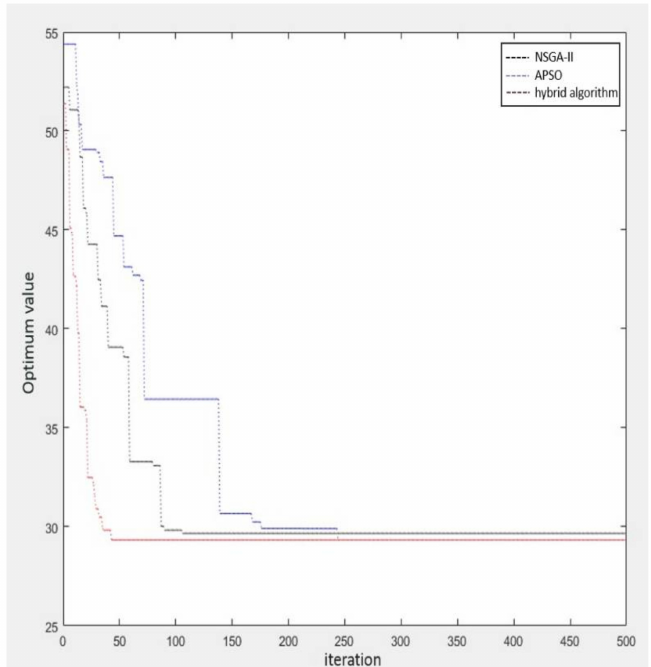
Figure 6. Comparison with classical traditional algorithms for optimizing F1.